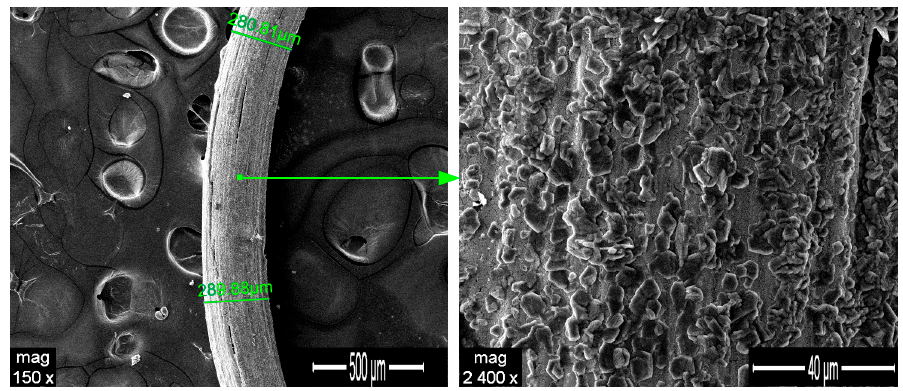
Figure 2. SEM image of the sulfonated HDPE/SKL (90:10) fiber (two-stage).